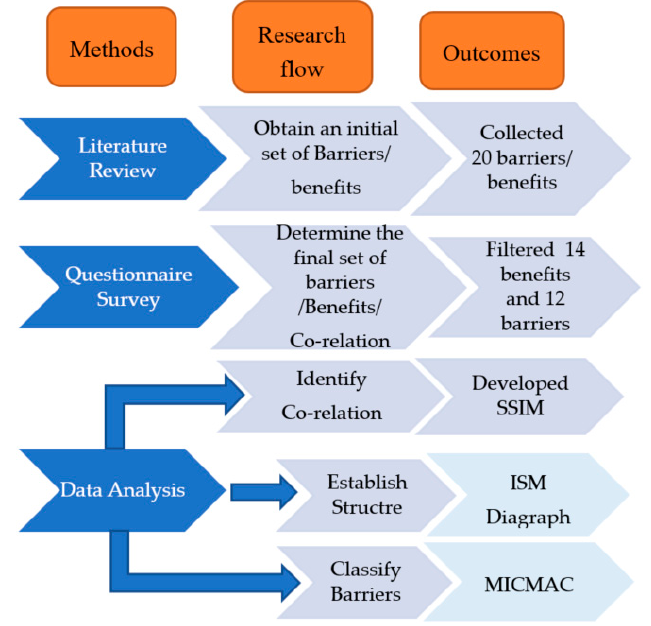
Figure 2. Research Flow.